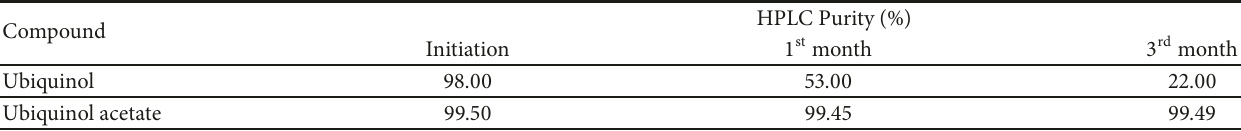
Table 1: Stability of ubiquinol and ubiquinol